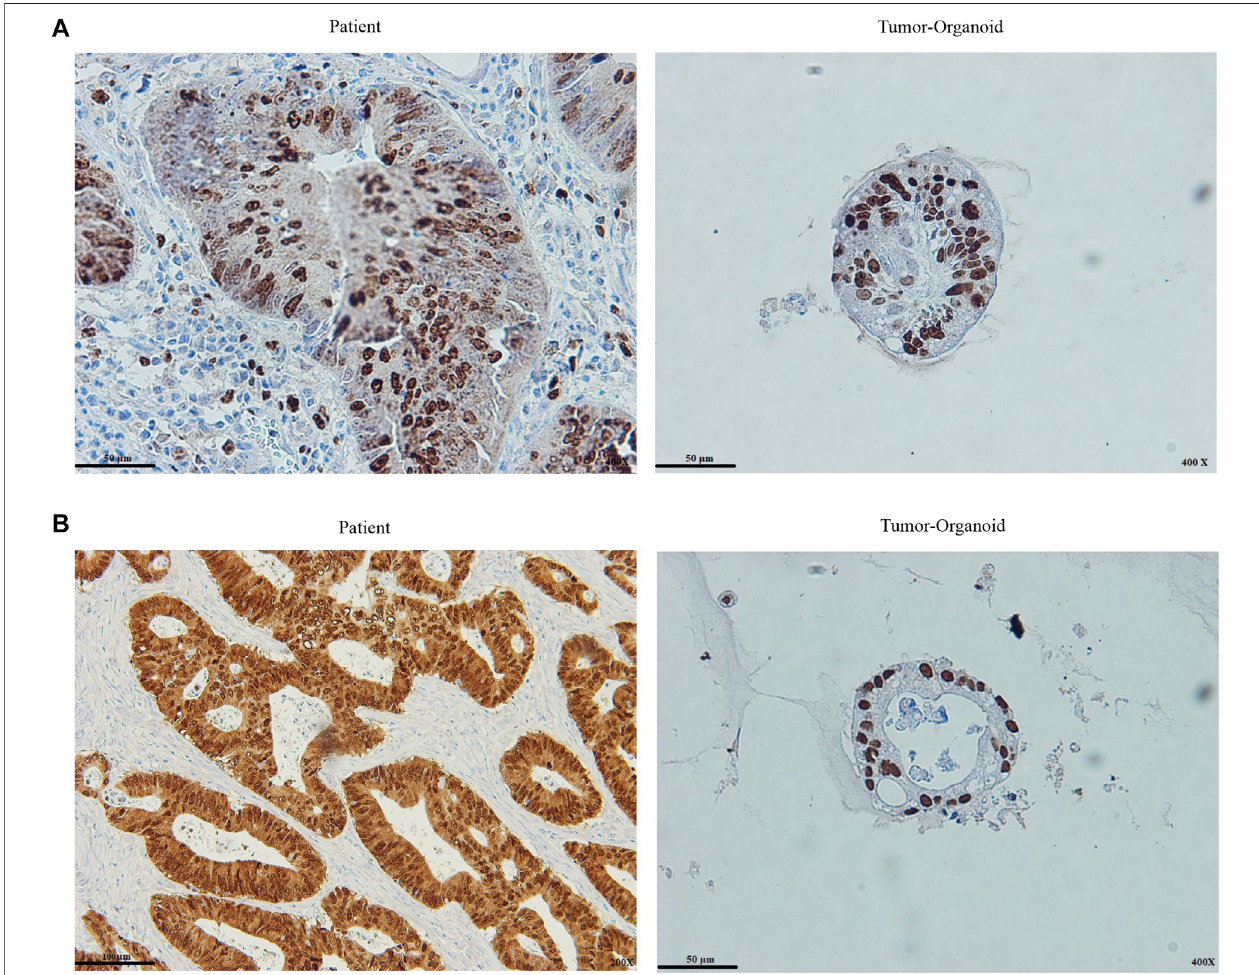
FIGURE 4 | Histopathological assessment of patient tumor and tumor organoid (A) Ki67 staining of the colon cancer organoids and original tumor (B) CDX2 staining ofthe colon cancer organoids and original tumor. Both stain intensity and presence quanti fi ed ki67 and CDX2. Intensity de fi nes staining strength, and presence is expressed as the percentage of cells with staining. The staining intensity is evaluated within the nuclear fraction. Scale bar: 50 μ m and 100 μ m, ×200 and ×400 magni fi cation.